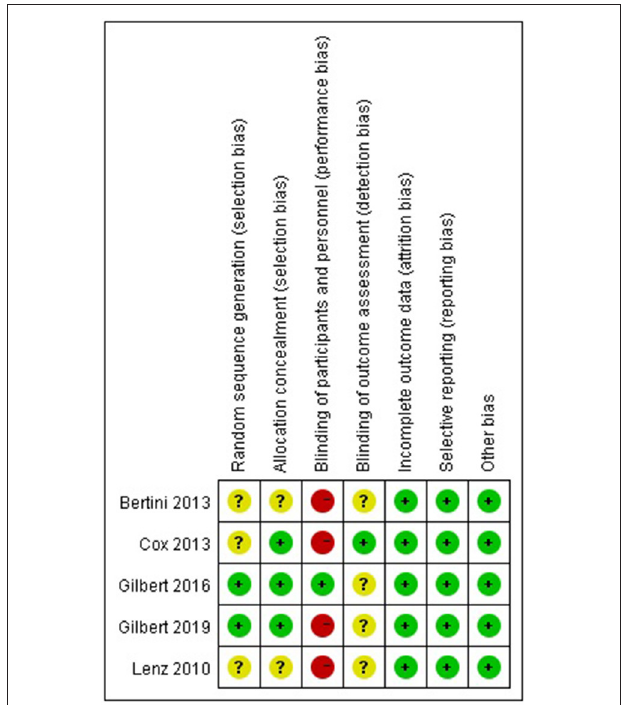
FIGURE 2 | Risk of bias